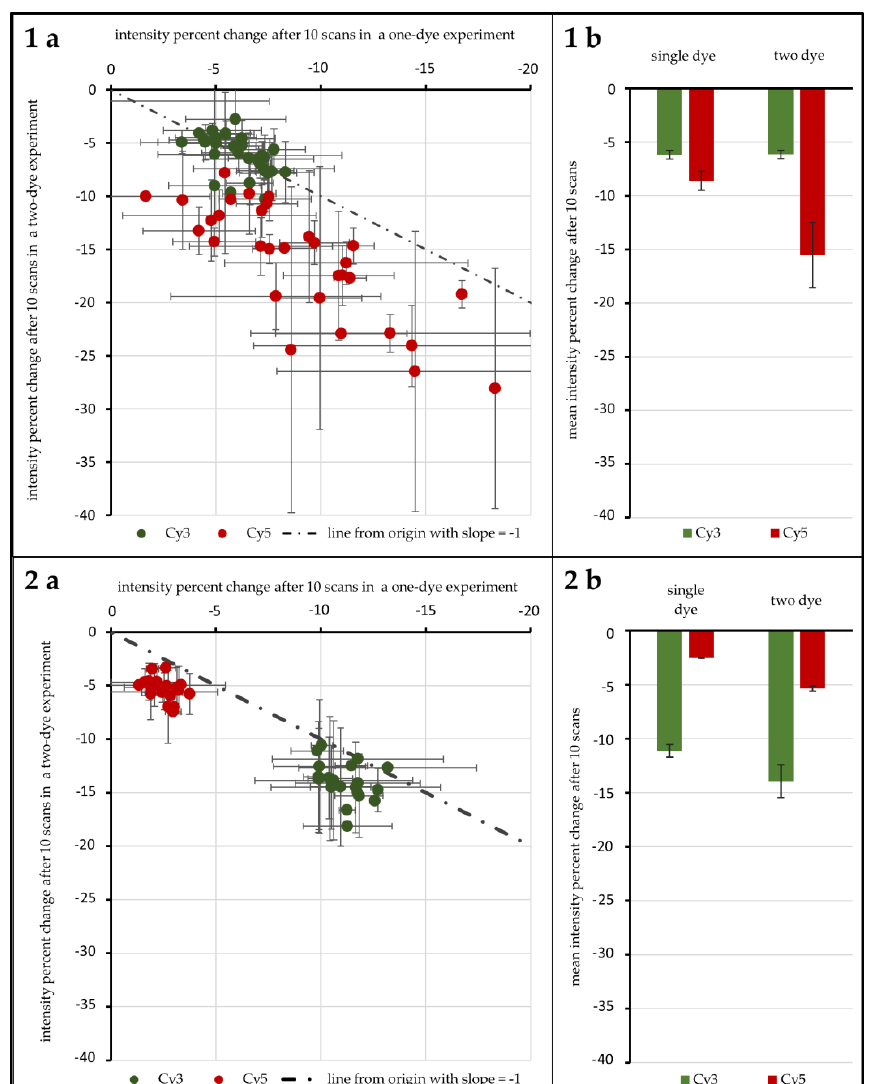
Figure 4. Results of the 96 gene experiment. The intensity percent change after 10 scans is compared for Cy3 and Cy5 depending on the presence/absence of their FRET partner. The percent change for one-dye setups is plotted against the same value derived from two dye experiments for unprotected spots ( 1a ) and spots protected by 1 mM ROXS in 1× PBS (phosphate buffered saline) ( 2a ). The dotted lines pass through the origin with a slope of −1. For each distribution the resulting means are given in ( 1b ) and ( 2b ). Error indicators are the respective standard errors (confidence: 95.4%) with Gaussian error propagation.